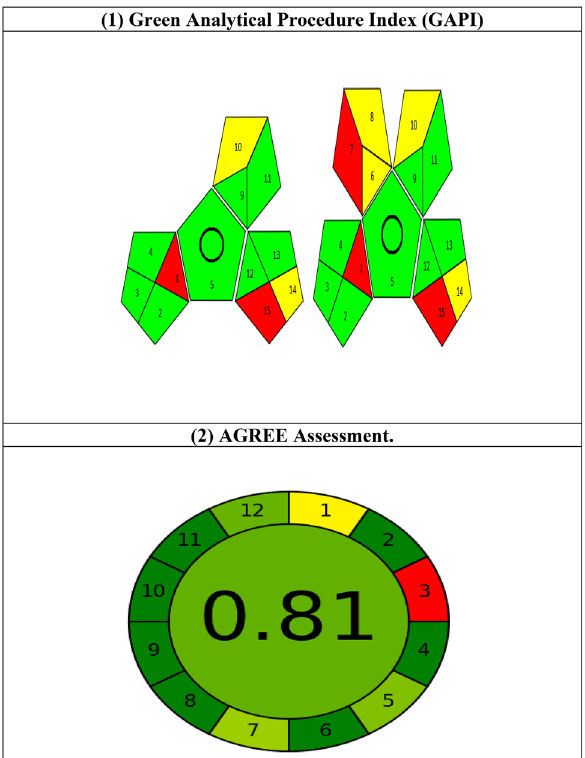
Figure 8. Results for evaluation of the greenness of the developed method by different green analytical chemistry metric